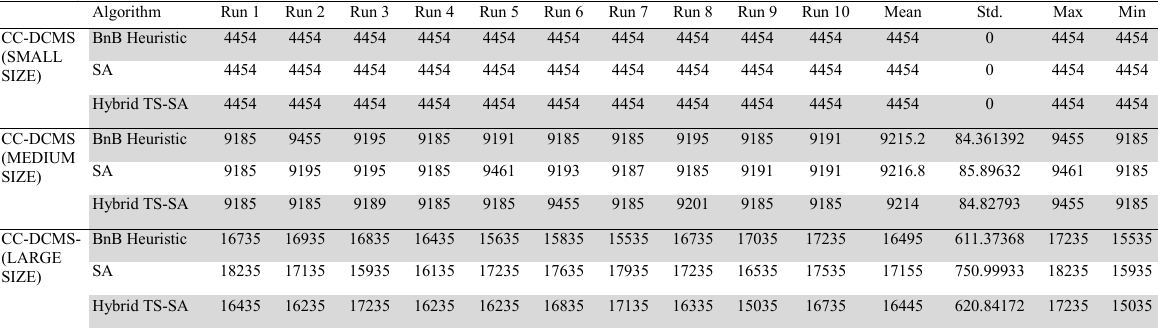
Solving mathematical problems with TS-SA and Branch and